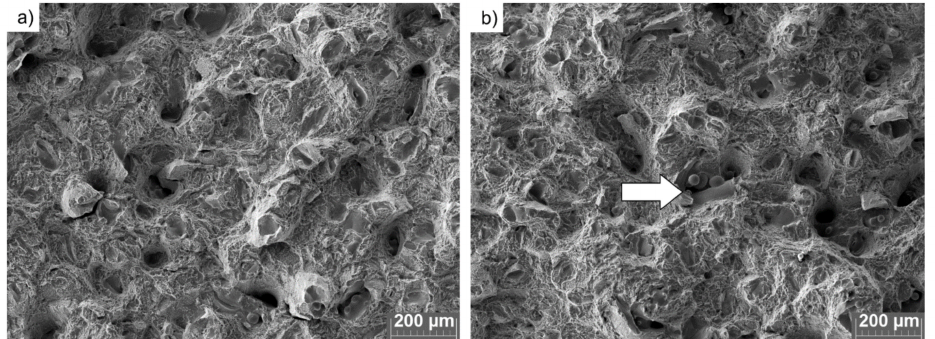
Figure 15. SEM photographs of fracture surfaces of Charpy-V samples: ( a ) FRESH and ( b ) USED powders. The arrow indicates the lack of